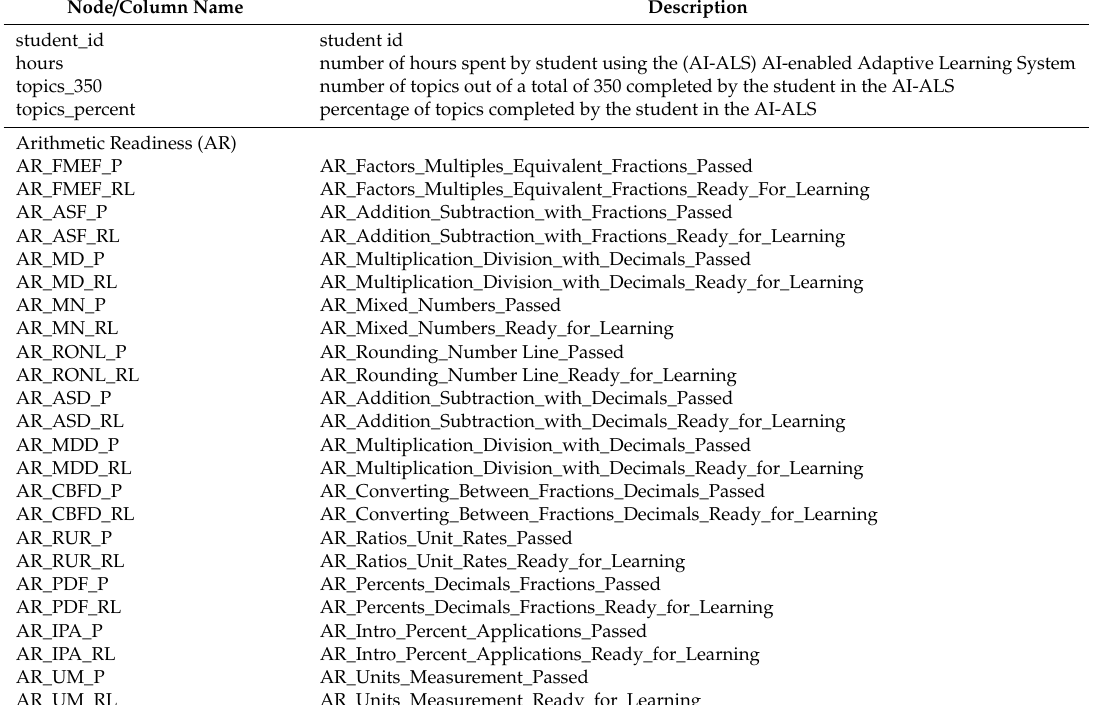
Table A1. Codebook of the columns in the dataset, each of which will become a node in the BN model. Node / Column